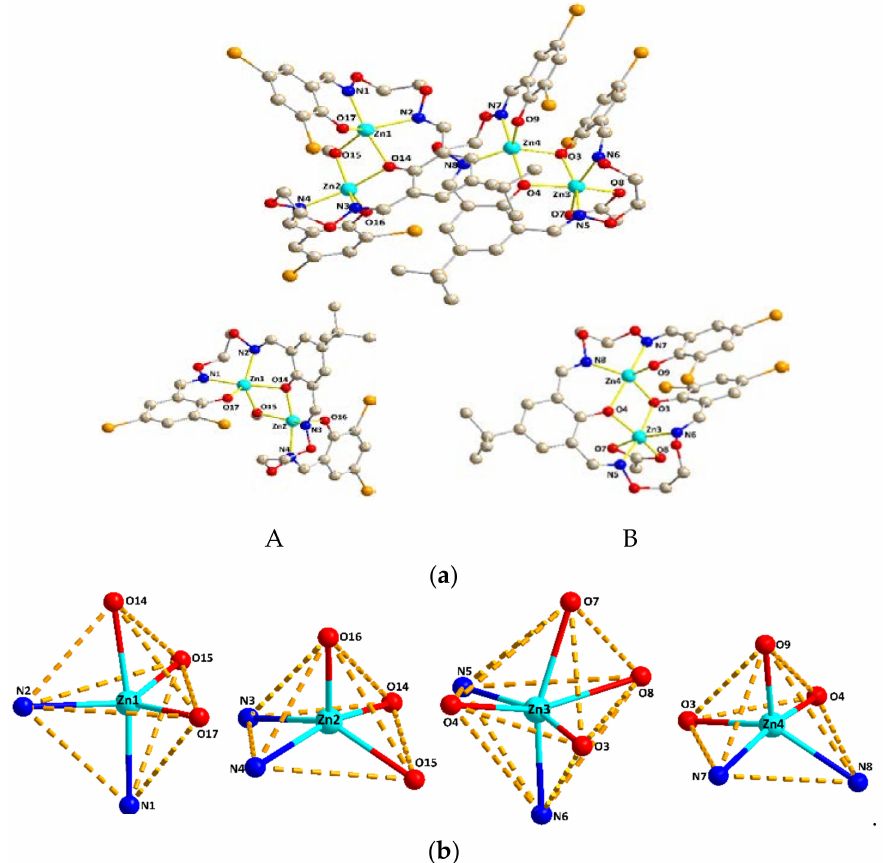
Figure 2. ( a ) Molecule structure and atom numberings of the coordination compound 2 (hydrogen atoms are omitted for clarity). ( b ) Coordination polyhedrons for Zn II atoms of the coordination compound 2